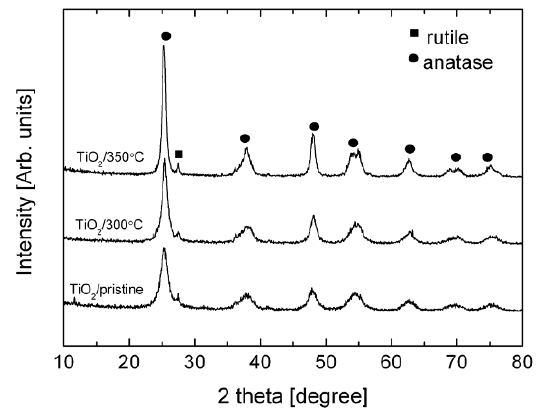
Figure 2. The UV-Vis/DR spectra of four unrinsed and rinsed samples. /pristine], 2